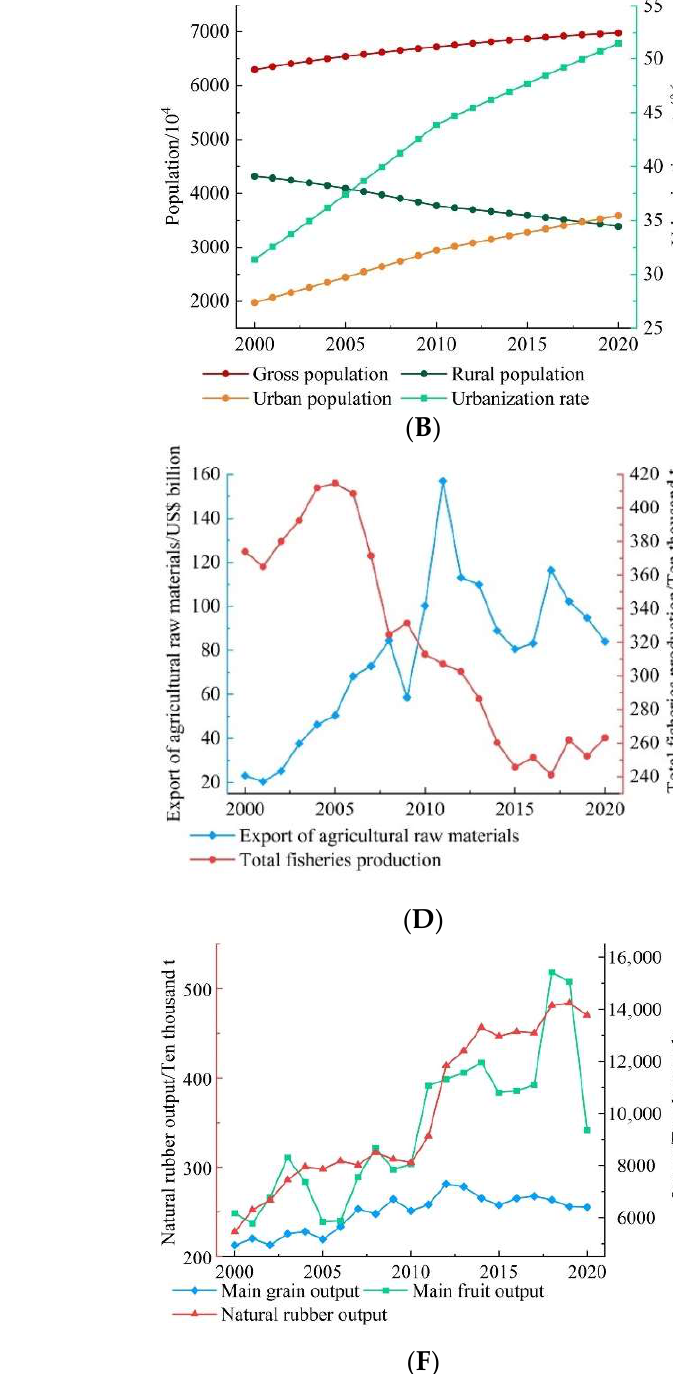
Figure 6. Development status of Thailand from 2000 to 2020. ( A ) Climatic factors; ( B ) population factor; ( C ) economic factor; ( D ) production and export factor; ( E ) tourism factor; and ( F ) agriculture factor.